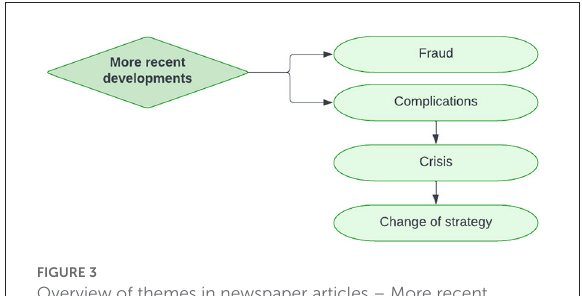
FIGURE3 Overview of themes in newspaper articles – More recent